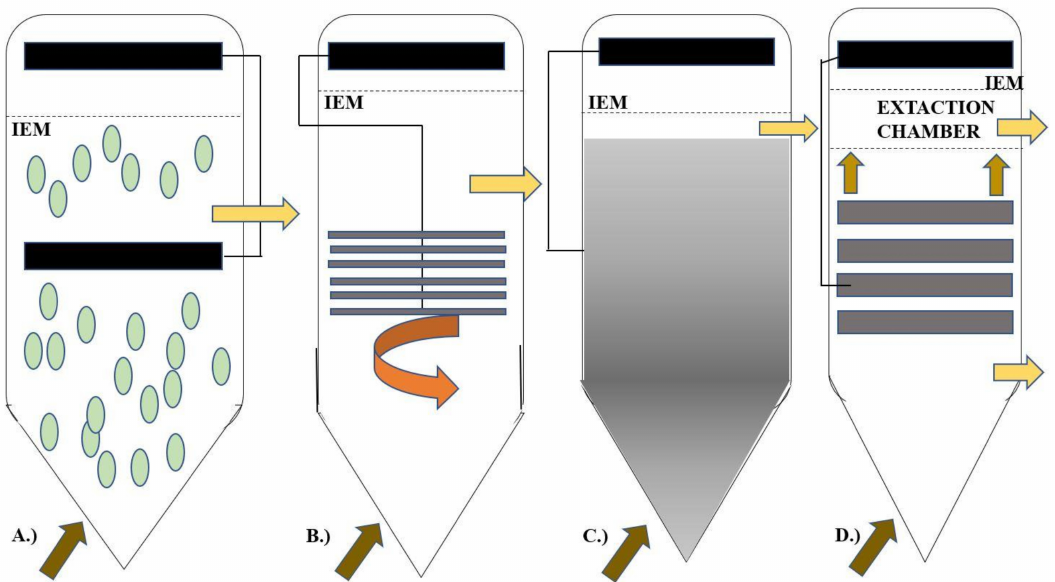
Figure 8. Diagrammatic representation of immobilized cells with di ff erent configurations: ( A ) fluidized bed, rotating, ( B ) bed packed bed, and biofilters ( C , D ). ( D ) the reactor contains in situ separation systems, along with three-chamber configurations. IEM, Ion-exchange membrane